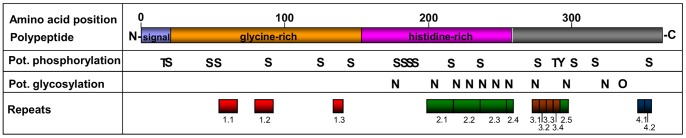
Structural overview of deduced consensus of He185/333 polypeptides.Approximate amino acid positions are given at the top, amino/carboxy-terimini are labeled with N and C to the left and right of the consensus, respectively. Polypeptides carry a signal sequence at the N-terminus, followed by glycine-rich and histidine-rich regions. Potential phosphorylated serine, threonine and tyrosine residues are marked with S, T and Y respectively and potential N- and O-linked glycosylations with N and O, respectively. Repeats, as shown for cDNA element patterns in figure 2A and in table S2, are shown at the bottom and are labeled with repeat type followed by copy number.